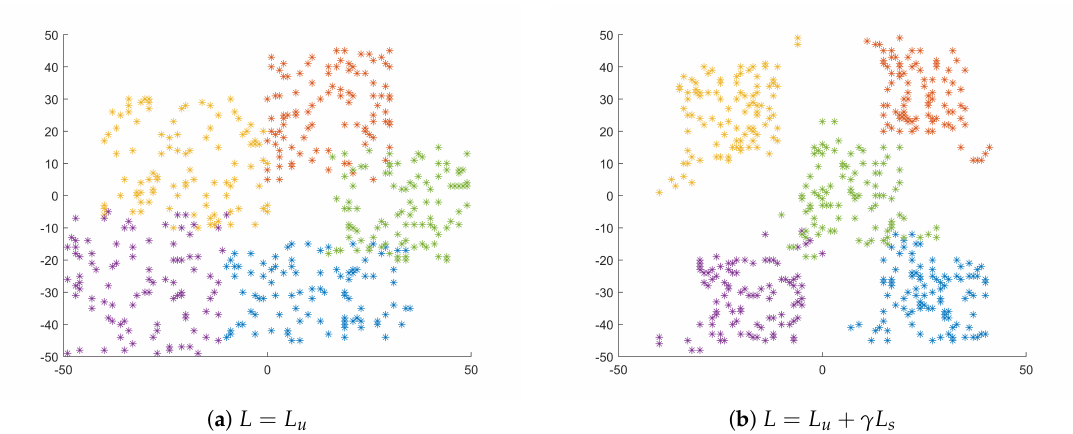
Figure 5. The visualization of class distribution in different objective loss performed. ( a ) shows the class distribution for single supervision of unsupervised loss L u , as DTEC performed. ( b ) shows the class distribution for joint supervision of unsupervised L u and semi-supervised loss L s , as SDTEC performed.